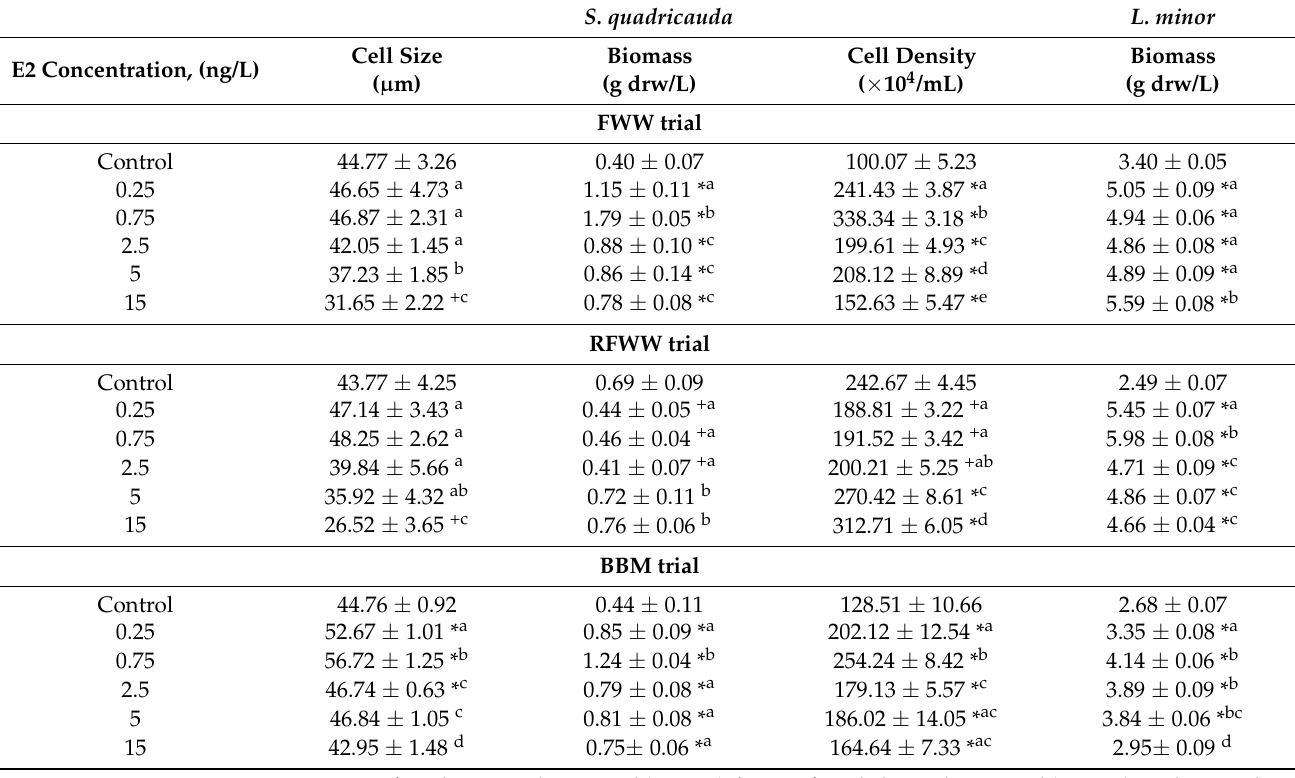
Table 1. Changes in growth parameters of Scenedesmus quadricauda and Lemna minor when cultured in the three growth media, on day 11 of the experiment (the day on which the experiment was